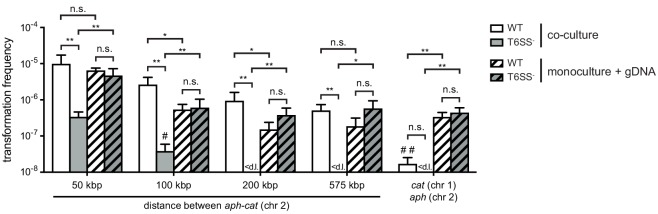
Combined data from Figure 1B and C comparing double-resistance acquisition efficiencies in co-cultures or in gDNA-supplemented monocultures.Data represent the average of three independent biological experiments (± SD). For values in which one (#) or two (##) experiments resulted in the absence of transformants, the detection limit was used to calculate the average and for statistical analyses. < d .l., below detection limit. Statistical significance is indicated (*p<0.05; **p<0.01; n.s., not significant).